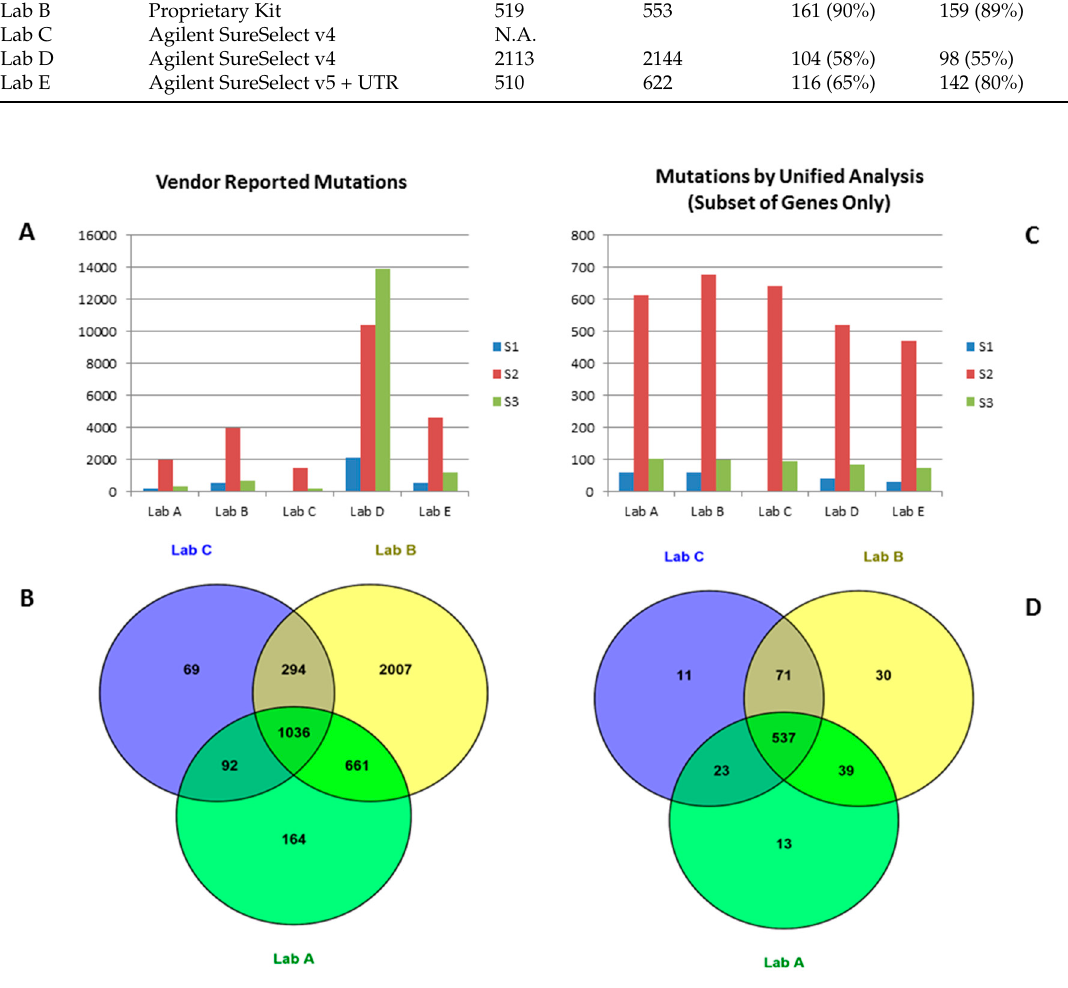
Figure 1. ( A ) Mutation number reported by all vendors for all three samples; ( B ) mutations reported by three top performing vendors (sample S2); ( C ) number of mutations detected by unified analysis of vendors’ fastq data. Only mutations in TruSight One gene panel regions were reported for all samples; ( D ) mutations detected by unified analysis of vendors’ fastq data. Only mutations in TruSight One gene panel regions were reported (sample S2).